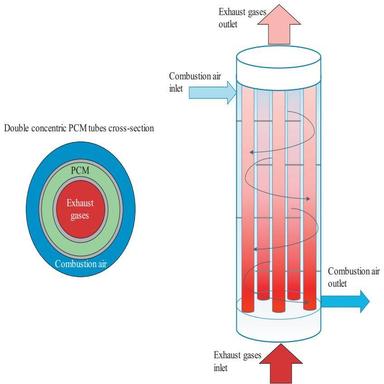
Diagram of a shell-tube PCM-TES with PCM contained into double concentric tubes.